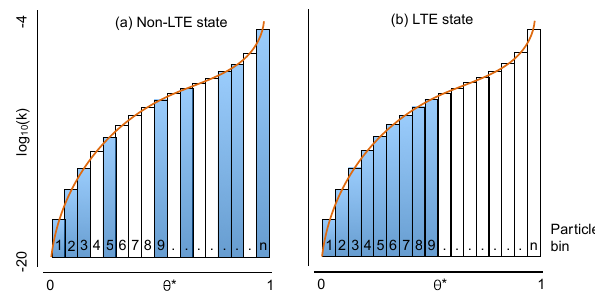
Figure 2. Example of delineation of the pore space into bins of equal volumes or particles in our study. If the bins are organised in ascending order, this refers to the LTE (local thermodynamic equi- librium) state of the pore space (b) . However, at the same over- all soil moisture the particle configuration could also divert from LTE (a)